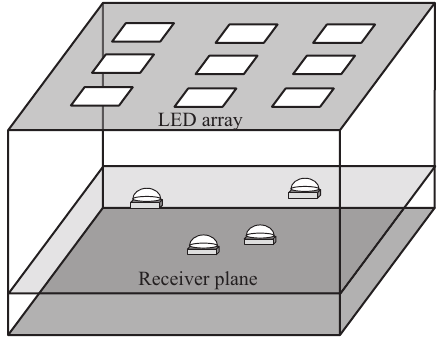
Figure 1. Multiuser VLC systems.